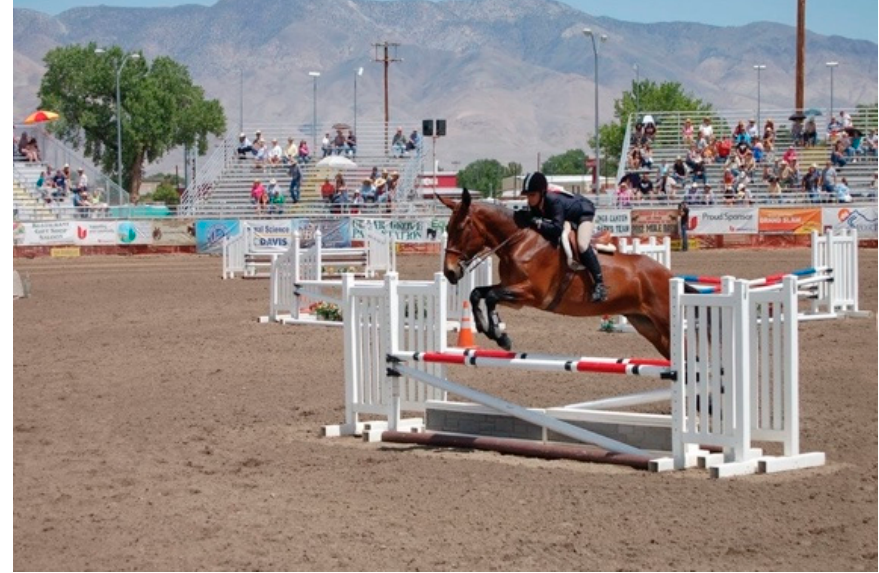
Figure 1. Mules and hinnies can be trained to compete in multiple disciplines, just like horses. The U.S. has seen a growth in mules, hinnies, and donkeys for recreation and competition mounts.